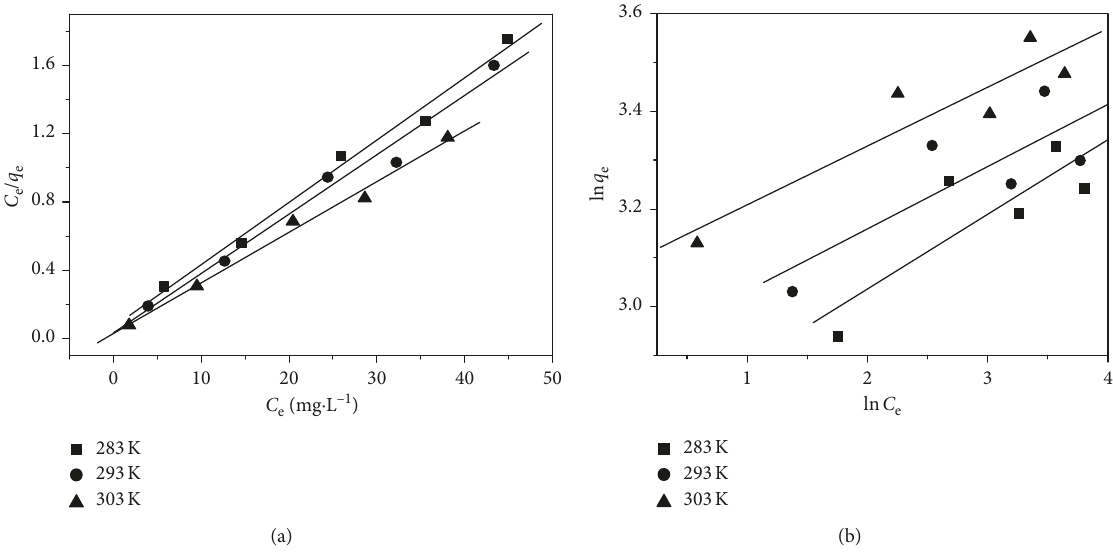
Figure 13: Plots of Langmuir (a) and Freundlich (b) isotherms in linear form for the adsorption of As(V) onto Al-B at several temperatures. Table 5: The parameters of isotherm models in linear form for the adsorption of As(V) onto modified bentonite. T